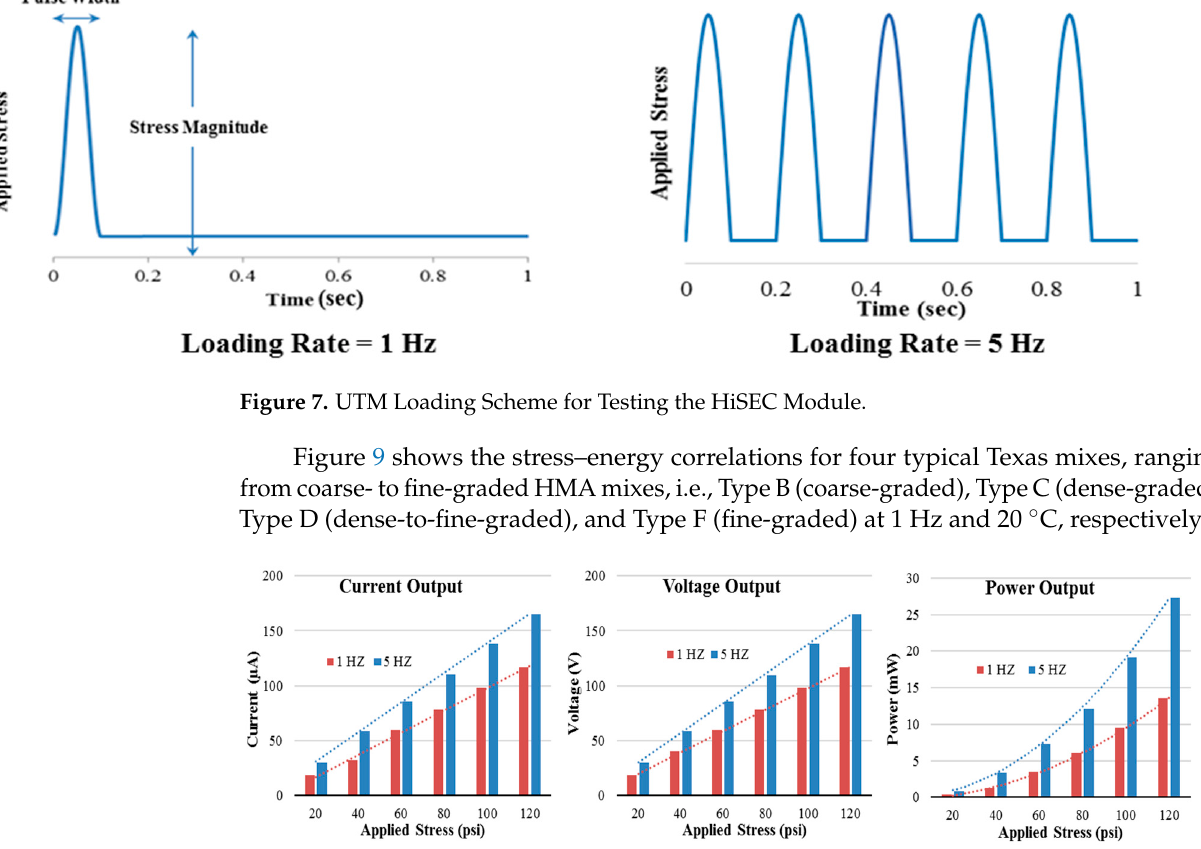
Figure 8. UTM-HiSEC Energy Generation—Frequency Variation (US 82, Type D, 20 °C).